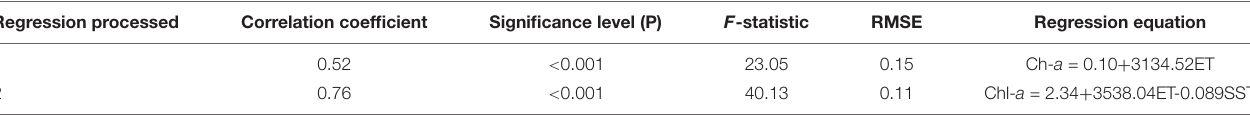
TABLE 4 | Correlation coefficient using a stepwise multiple linear regression, significance level, F -statistic, RMSE and regression equation.